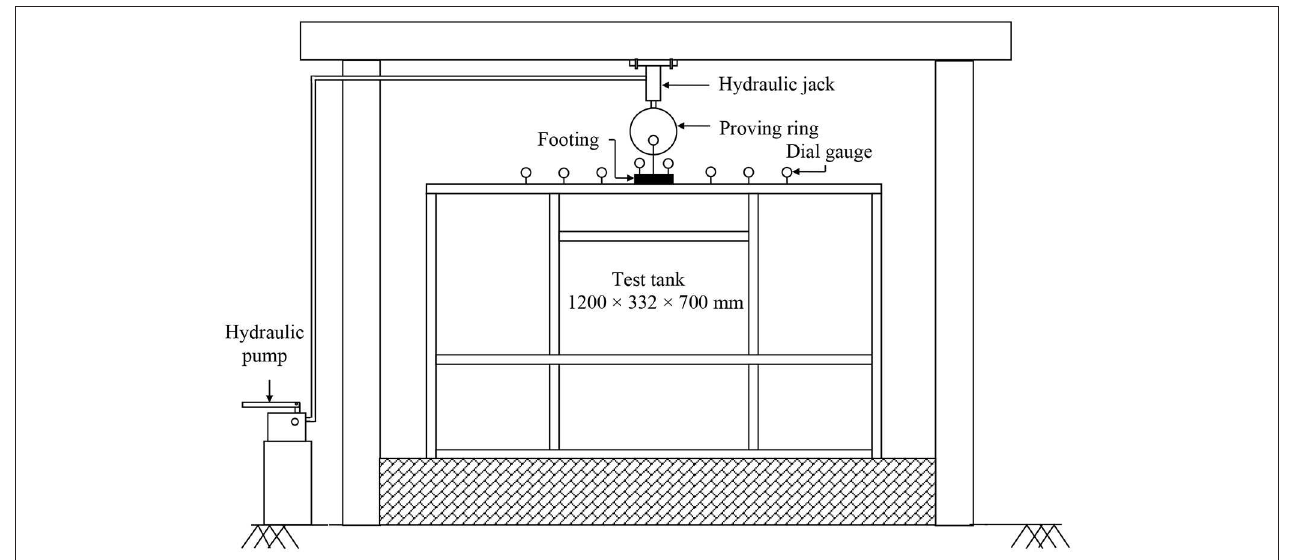
FIGURE 1 | Test setup.